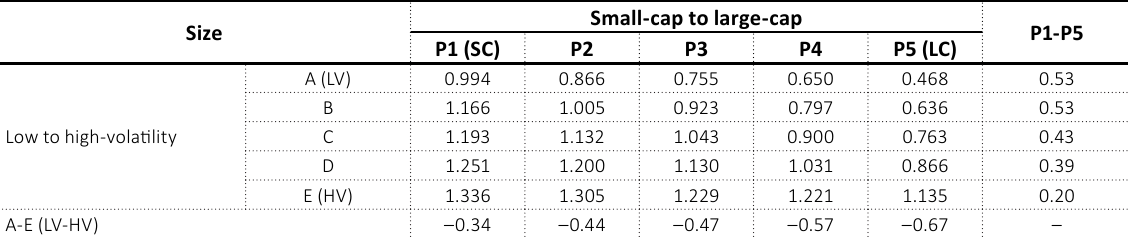
Table 5. Ex-post beta ratio of quintile portfolios independently sorted on size and volatility Size